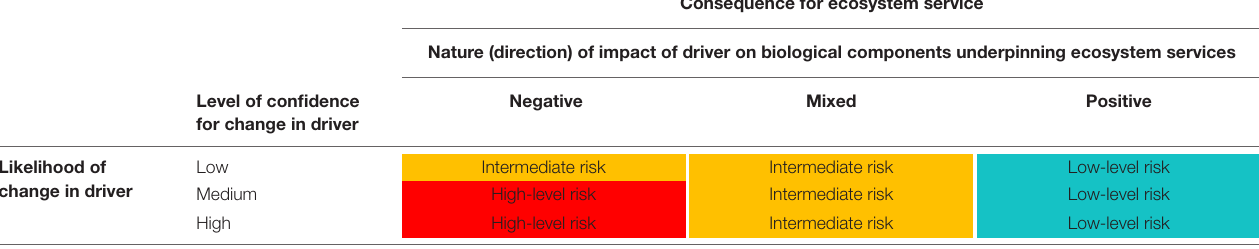
TABLE 1 | Look-up risk table for ecosystem